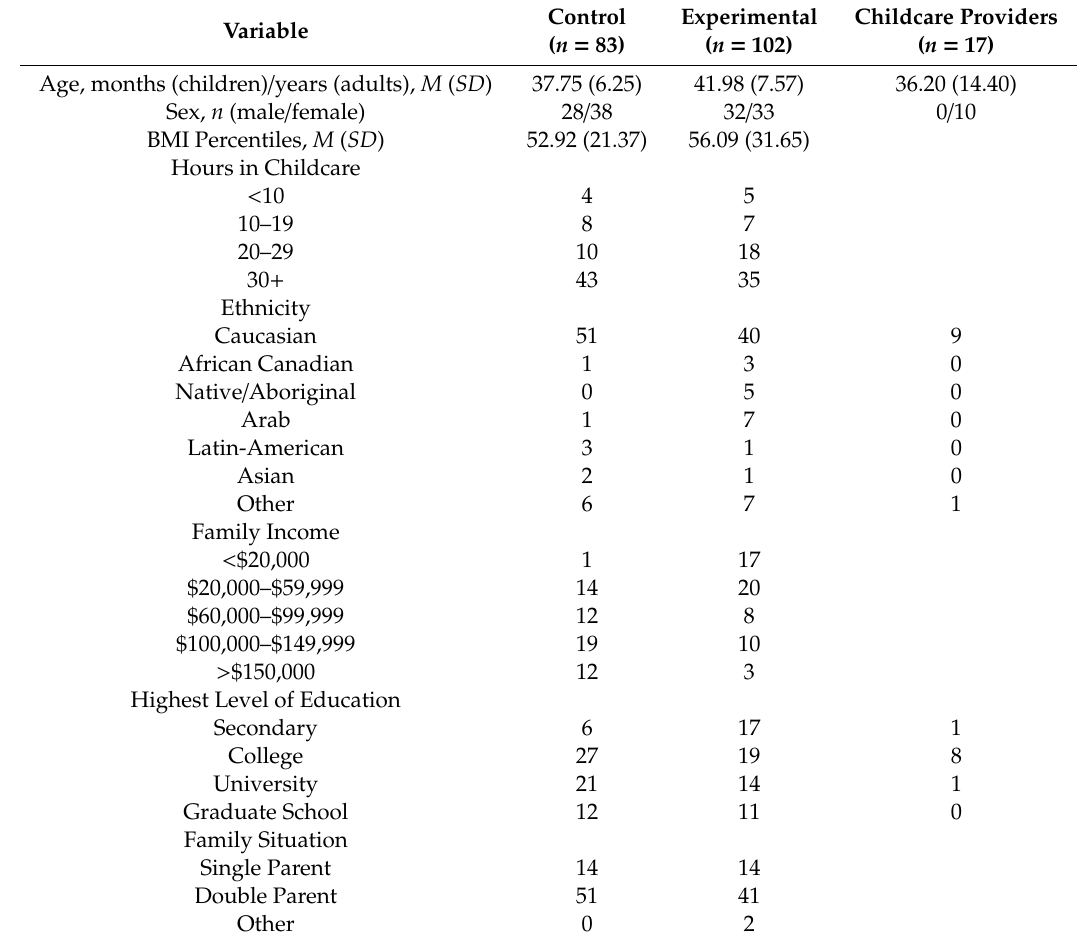
Control Experimental Childcare Providers ( n = 83) ( n = 102) ( n = 17)